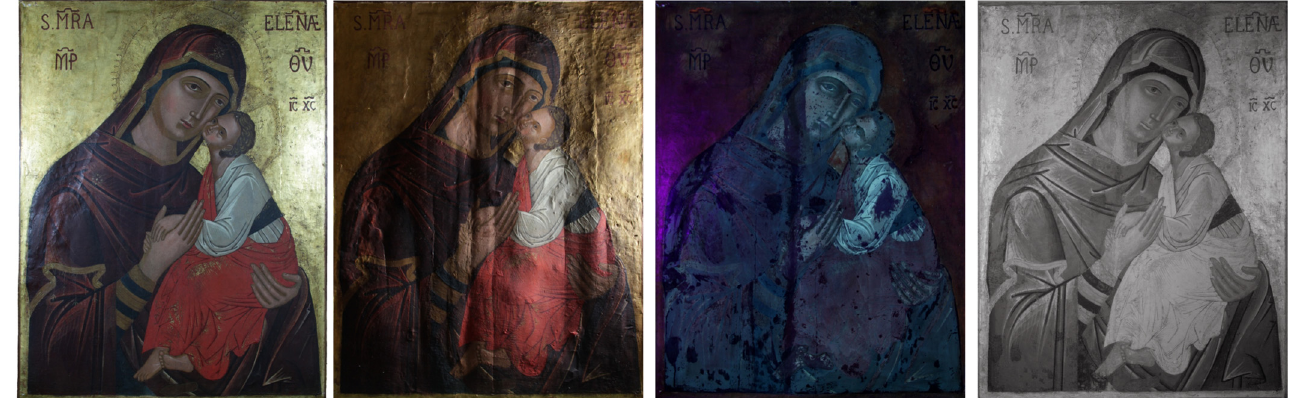
Figure 1. The Icon Madonna dell’Elemosina (Biancavilla (CT), Italy). From ( left ) to ( right ): photo in diffused vis light; vis grazing light; UV fluorescence; IR reflectography.